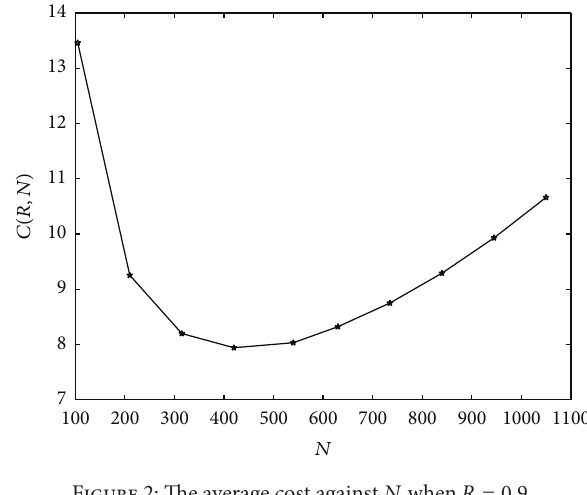
Figure 2: The average cost against 𝑁 when 𝑅 = 0.9 .